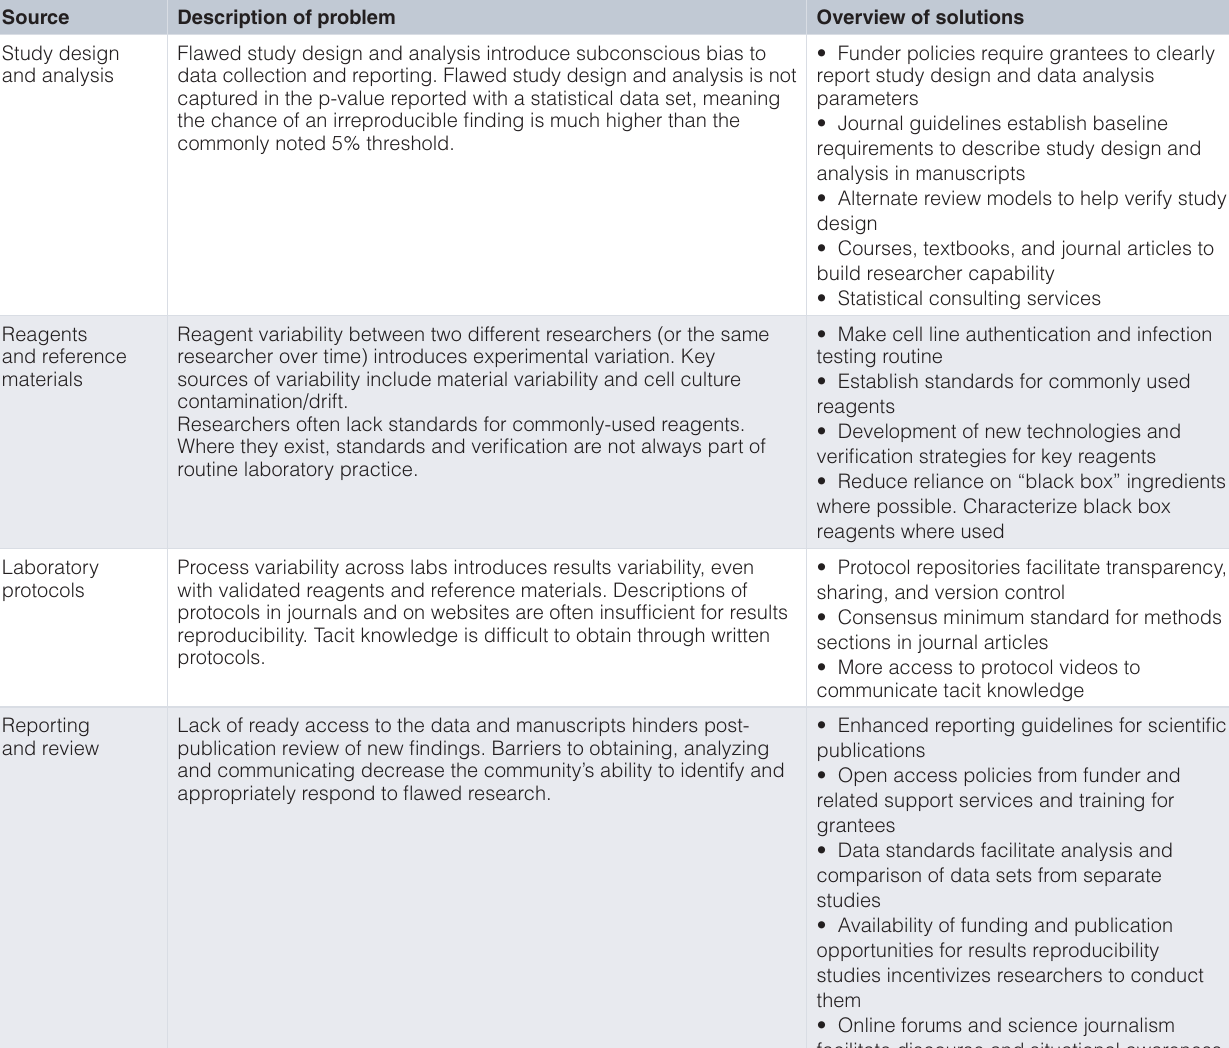
Table 1. Key sources of irreproducibility and